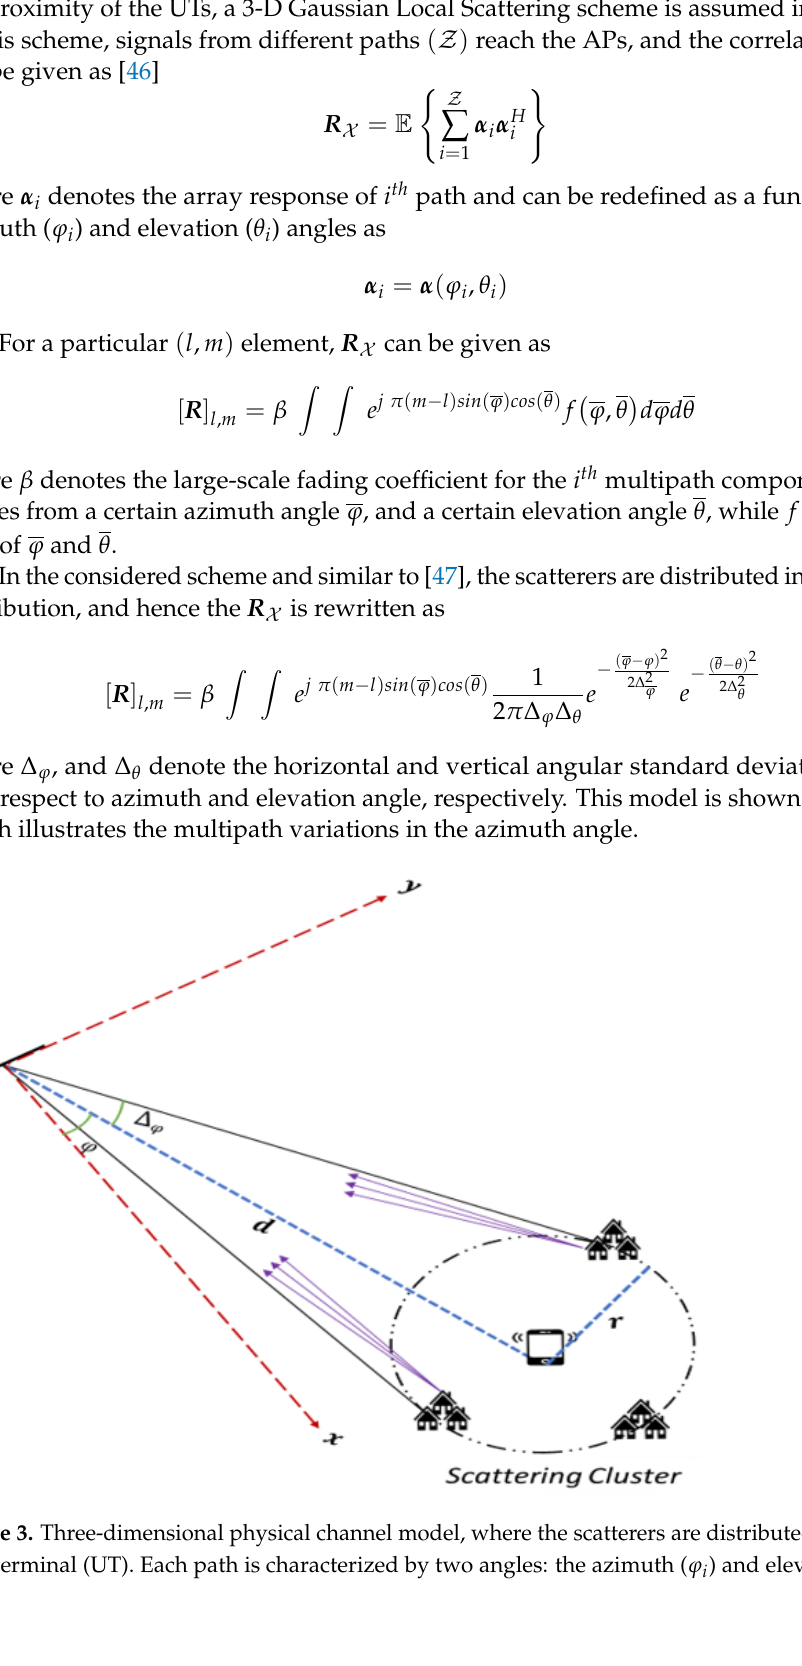
where 𝑟 and 𝑑 denote the radius and the horizontal distance. The mean elevation angle and the vertical ASD are defined with respect to the maximum and minimum elevation angles as follows. Maximum elevation angle can be achieved by a scatterer located at a distance 𝑑 − 𝑟 and defined as